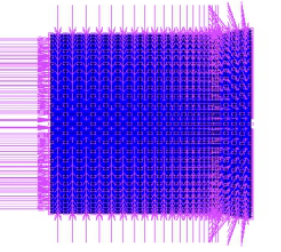
Figure 7. Thermal boundary conditions